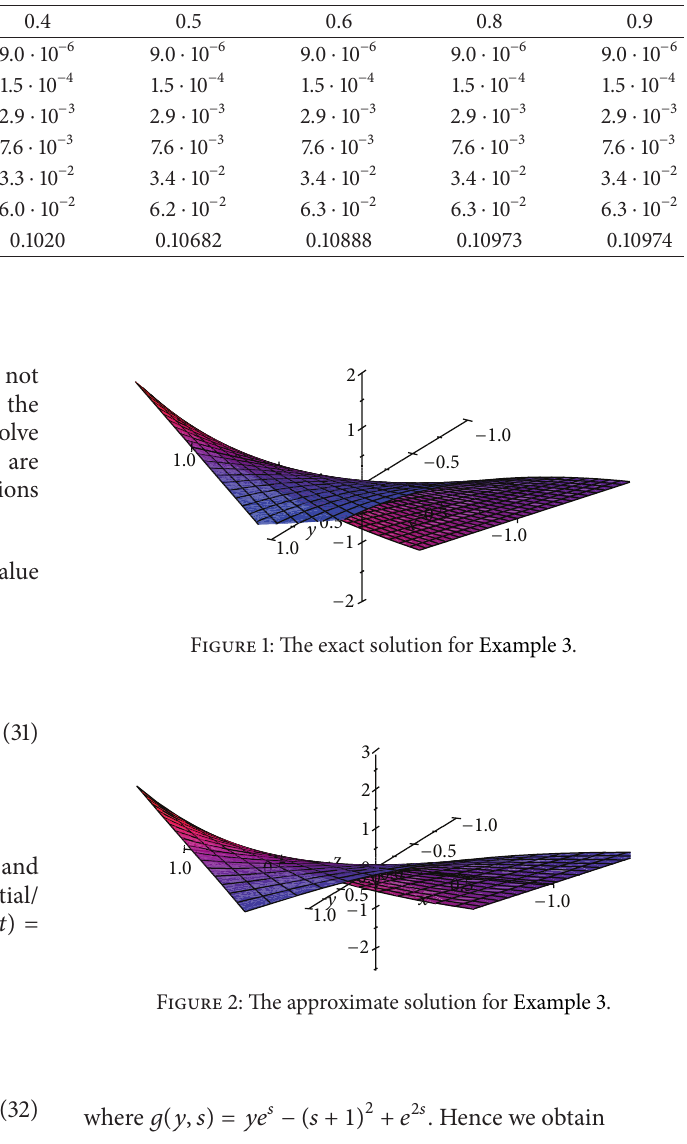
Table 1: Maximum errors for Example 3.